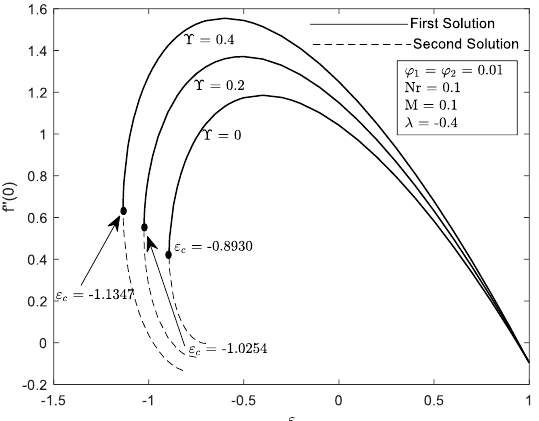
Figure 6. Variation of 𝑓 ′′ (0) with velocity parameter, 𝜀 for different ϒ.